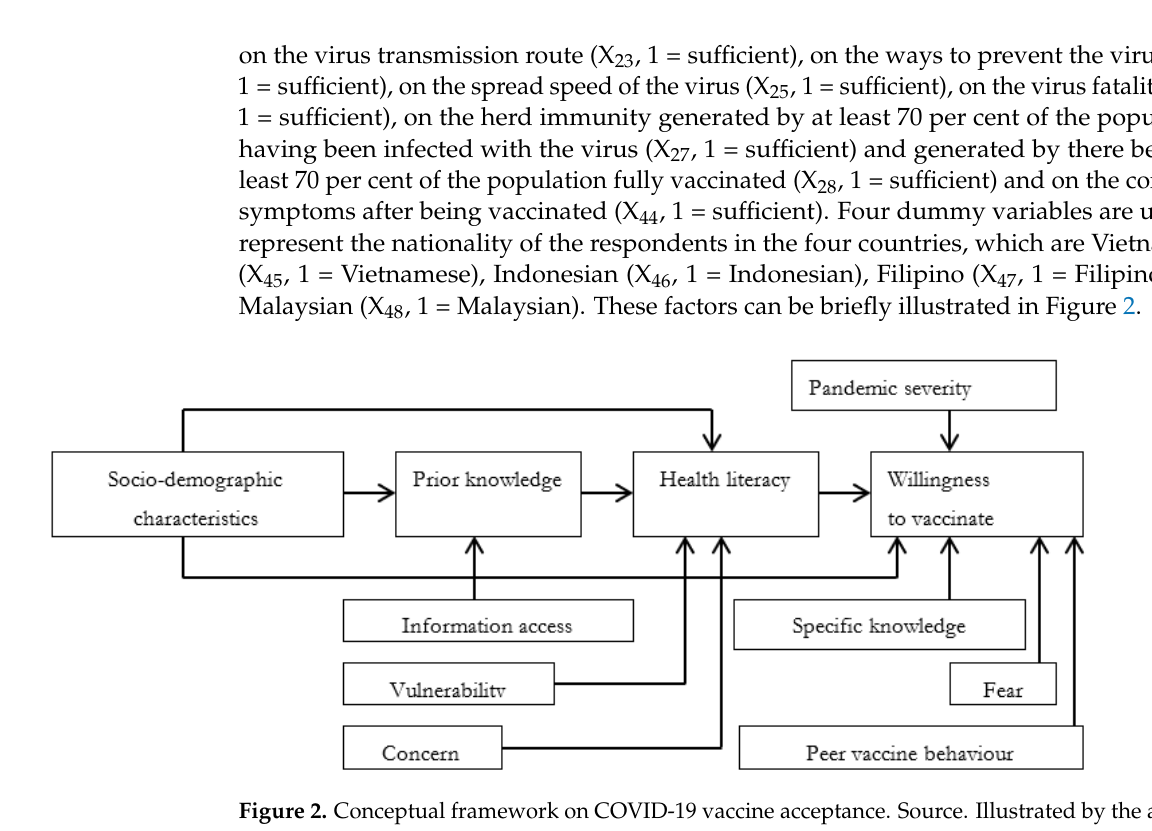
Figure 2. Conceptual framework on COVID-19 vaccine acceptance. Source. Illustrated by the au- thors with ideas adapted from Sun, Shi [37]. with ideas adapted from Sun, Shi